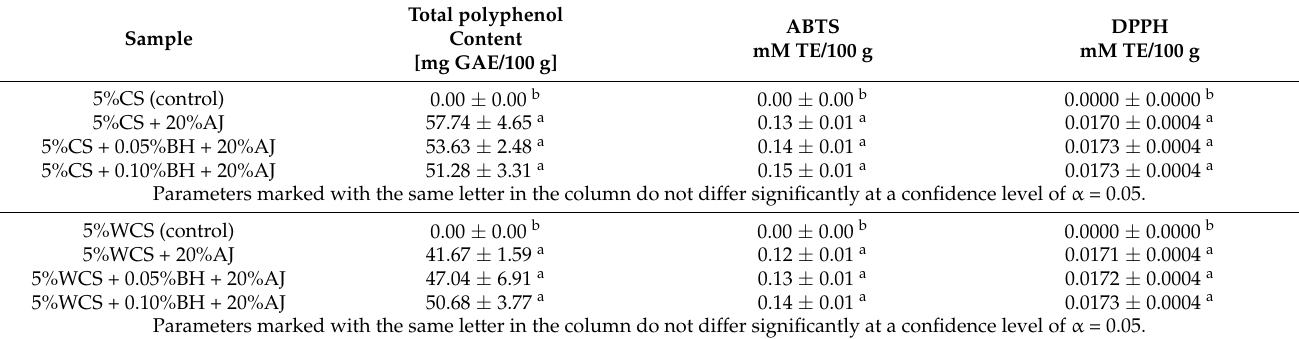
Table 9. Total polyphenol content in samples with normal and waxy corn starch, buckwheat fiber and